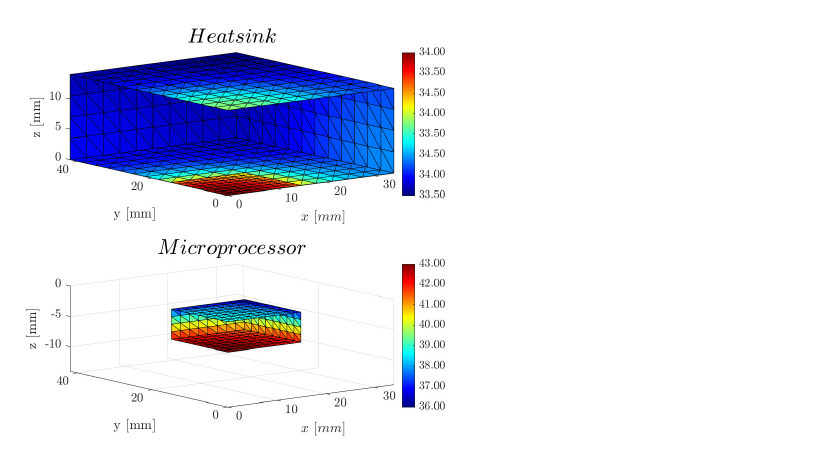
Figure A3. Complete temperature distribution ( θ [ ◦ C]) comparison at the base of the microprocessor for the uniform clamping pressure and Winkler elastic supports.